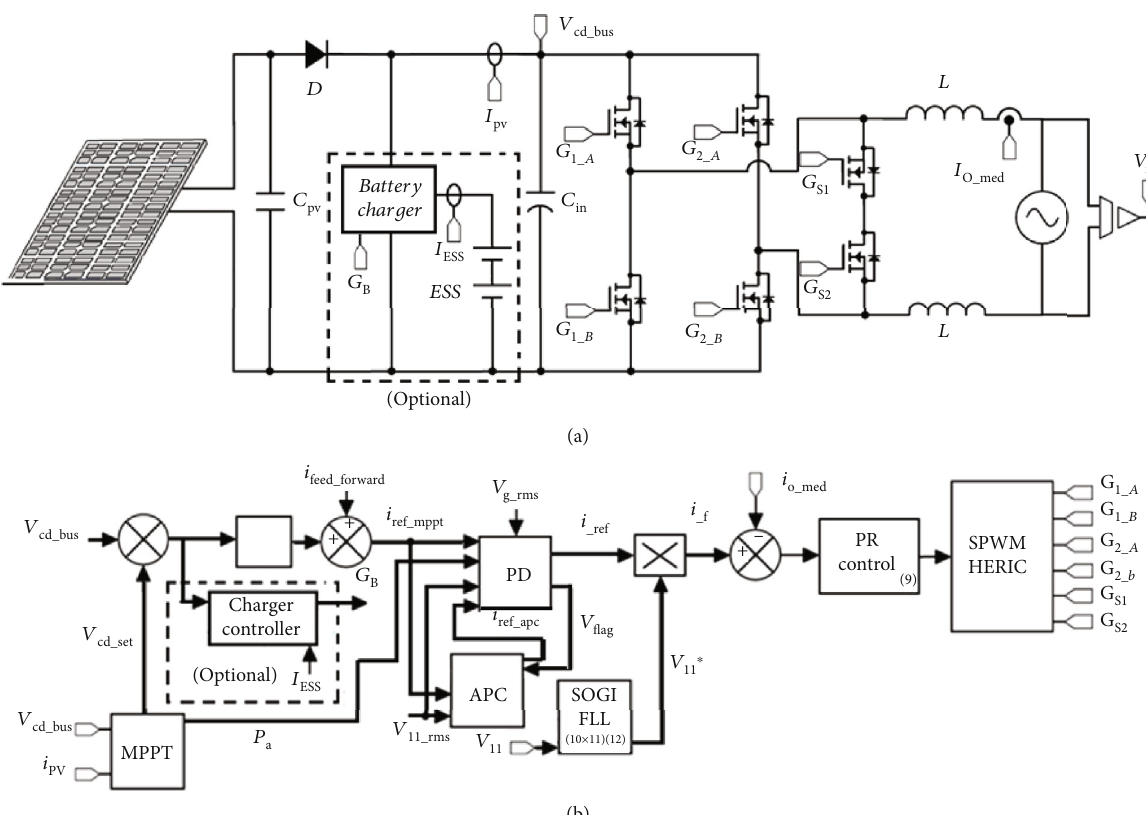
Figure 3: Proposed system: (a) power stage; (b) proposed controller.